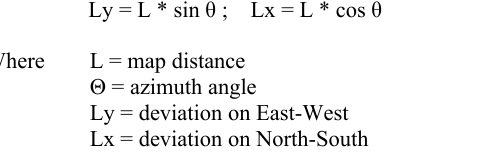
Figure 5. Accuracy (map distance) in East-West direction